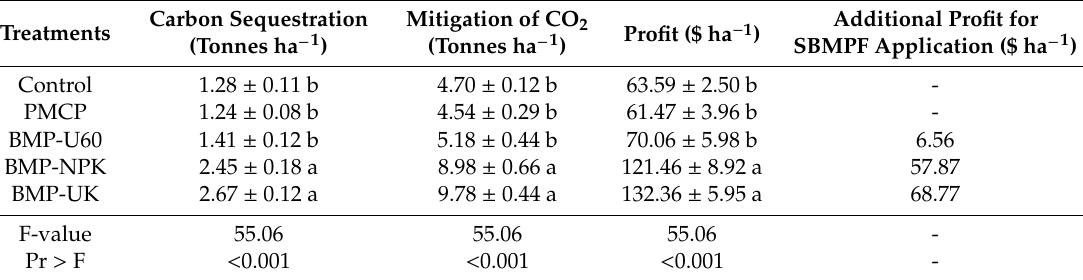
Table 5. Evaluation of carbon sequestration and its profit analysis for application of supplemented biochar manure pellet fertilizers during rice